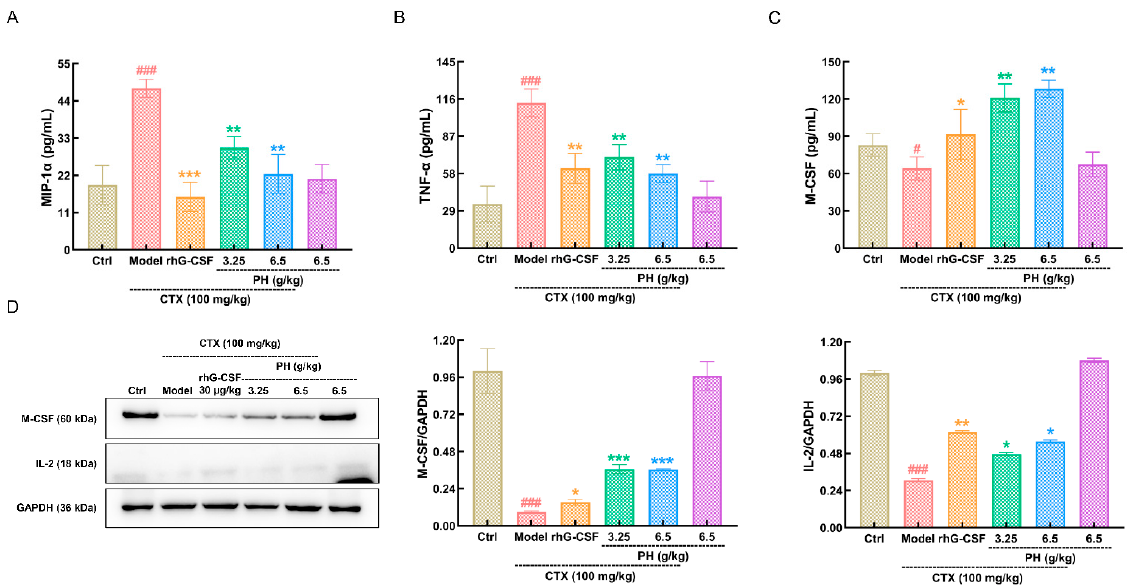
Figure 3. PH regulated the cytokines and proteins related to hematopoiesis. In CTX-induced mice with hematopoietic dysfunction, PH suppressed the levels of ( A ) MIP-1 α and ( B ) TNF- α , and enhanced the levels of ( C ) M-CSF in serum ( n = 6 mice/group in triplicate). ( D ) PH enhanced the expression levels of M-CSF and IL-2 in spleen ( n = 6 mice/group in triplicate). Data are showed as the mean ± SD and analyzed via a one-way ANOVA test followed by a Tukey’s post hoc test comparison. Quantification data were normalized by GAPDH, and reported as the percentage of those from the corresponding control mice. # p < 0.05 and ### p < 0.001 vs. control group, * p < 0.05, ** p < 0.01 and *** p < 0.001 vs. model group. CTX, cyclophosphamide; Ctrl, control; Model, hematopoietic dysfunction model; rhG-CSF, recombinant human granulocyte colony-stimulating factor; PH, Protein hydrolysate injection; M-CSF, macrophage colony stimulating factor; TNF- α , tumor necrosis factor- α ; IL-2, interleukin-2.